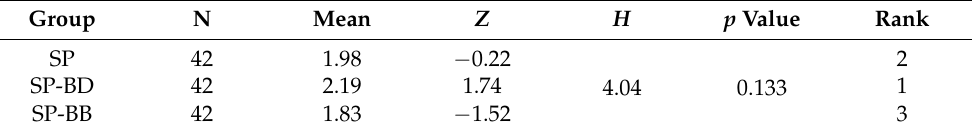
Table 3. Quantitative descriptive sensory analysis using the ranking scale method. Group N Mean Z H p Value Rank